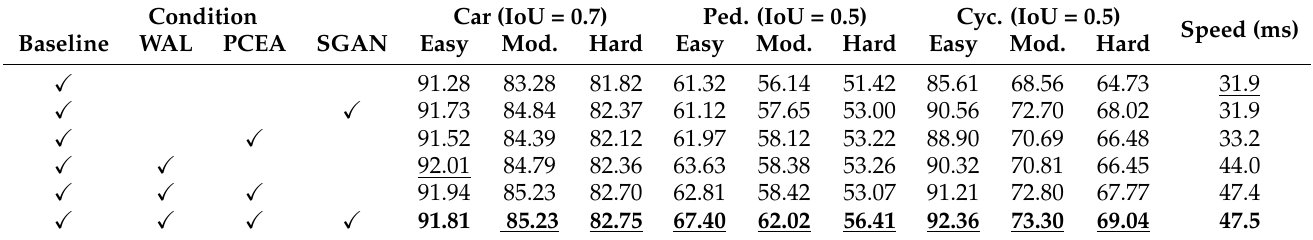
Table 4. Ablation studies on proposed modules: SGAN, PCEA, and WAL. The mean average precision is measured with 40 recall positions AP 40 . The results of our SGSSD are shown in bold, and the best results are